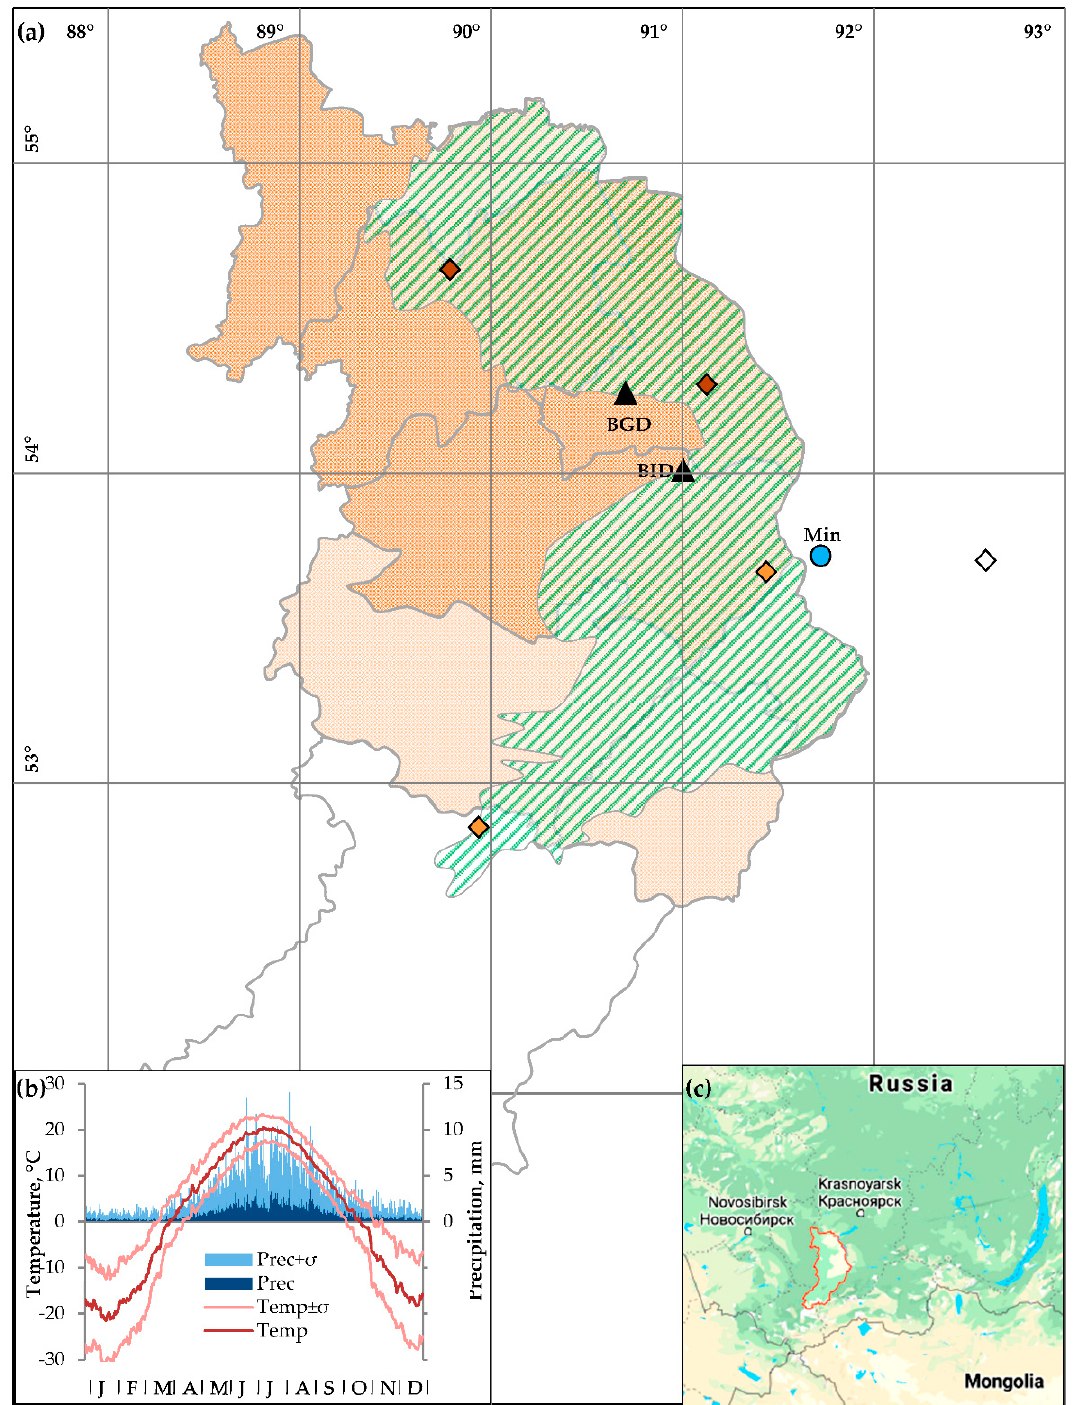
Figure 1. Study area: ( a ) Administrative map of the Republic of Khakassia. Hatched area is the most suitable for agri- culture plains of Khakass-Minusinsk Depression; administrative districts and state variety-testing stations ( ) are colored in accordance to agroclimatic classification according to Babushkina et al. [40]: rain fed moderately dry Northern zone (dark shaded area, ), irrigated dry Central zone (light shaded area, ); Karatuz variety-testing station outside of Khakassia used as a source of phenological data ( ). Locations of Minusinsk climatic station ( ) and dendrochronological sampling sites ( ) are marked. ( b ) Climatic diagram at the Minusinsk climatic station: daily series of air temperature (lines) and precipitation (bars) averaged over 1936–2017 (dark shades) and their standard devi- ations (light shades). ( c ) Location of the Republic of Khakassia in the South Siberia.